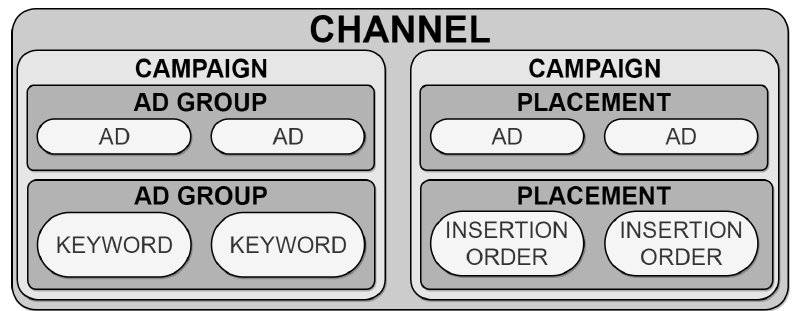
Figure 2. Distribution of the different levels for the elements in the marketing platforms